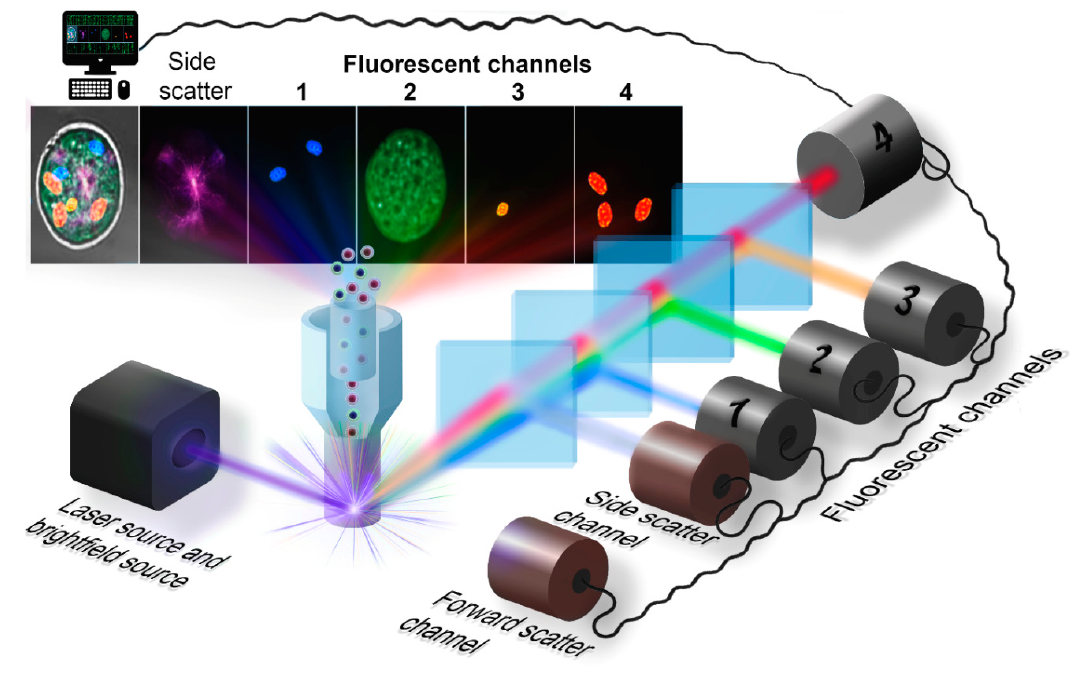
Figure 1. The optical system of an imaging flow cytometer.